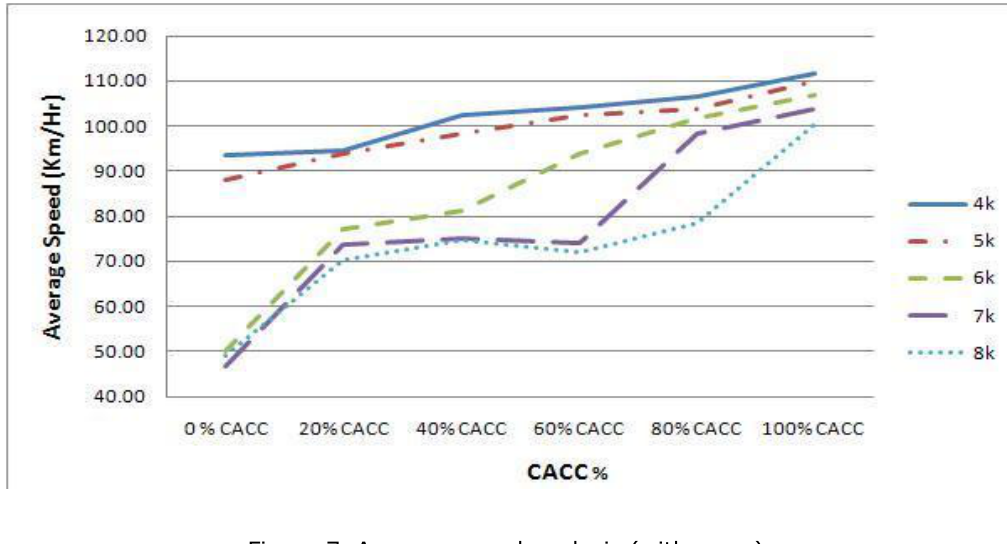
Figure 7. Average speed analysis (with ramp)